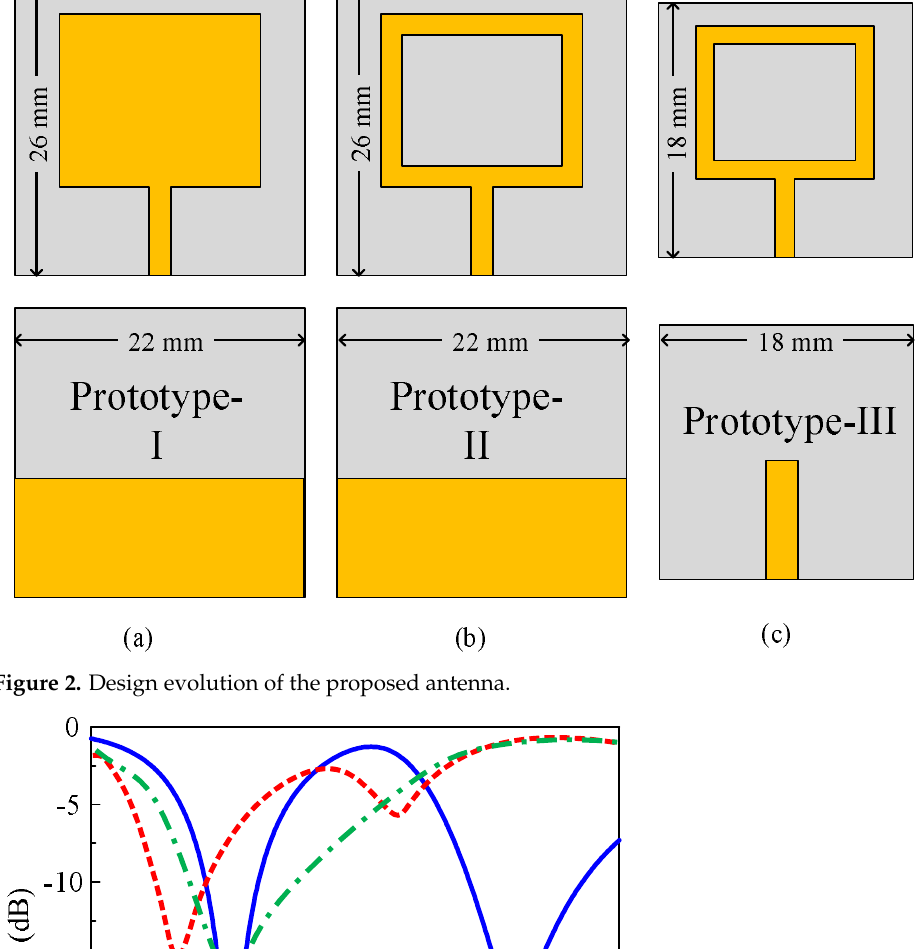
Figure 2. Design evolution of the proposed antenna.